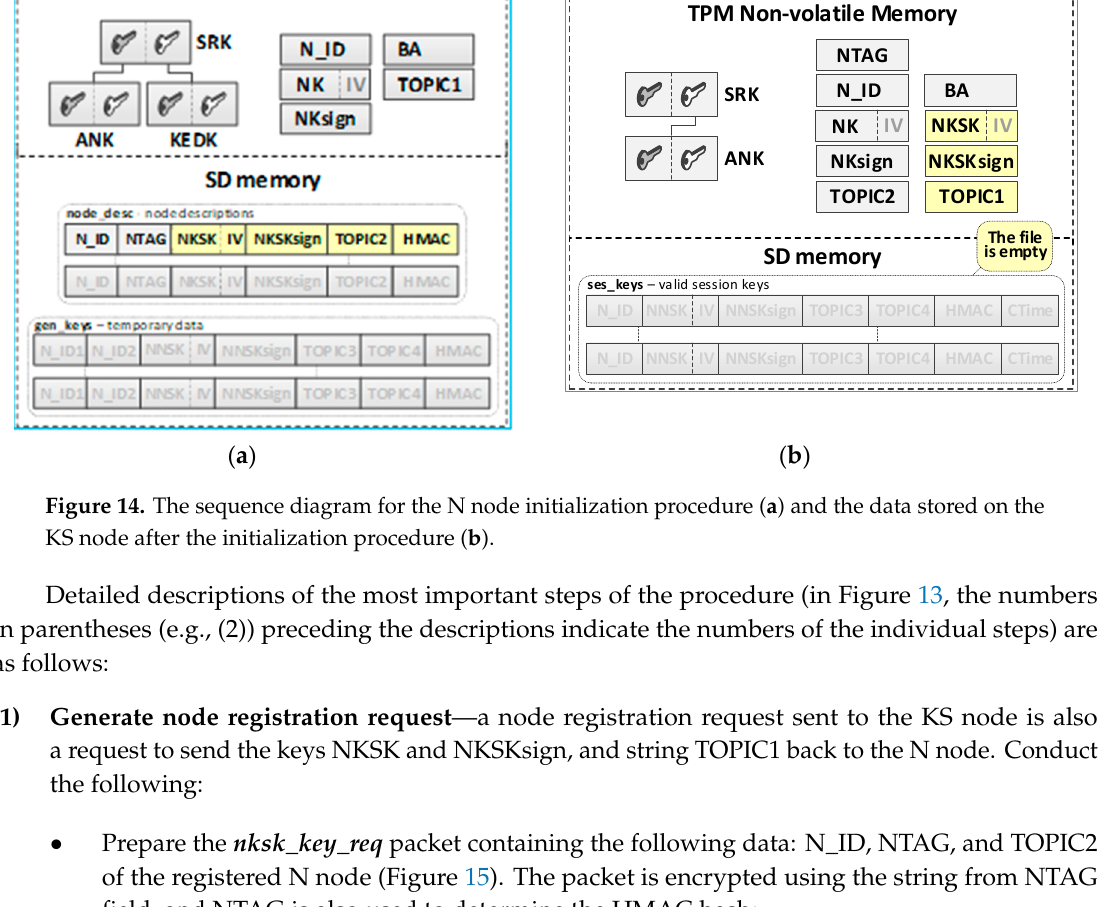
Figure 13. The sequence diagram for N node registration procedure.